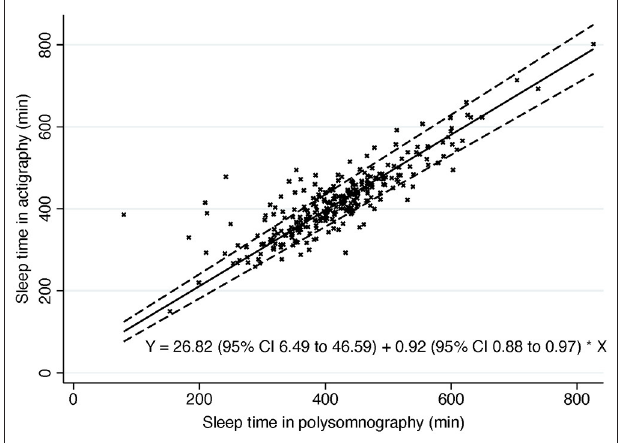
FIGURE 1 | Passing-Bablok of sleep time. Dashed line, 95% confidence interval. Solid line, Passing-Bablok regression line. Y, Passing-Bablok fit.